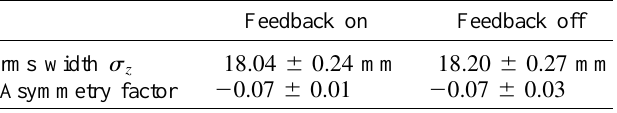
TABLE X. The electron bunch length and asymmetry factor when the instability is present (feedback off) and not present (feedback on).